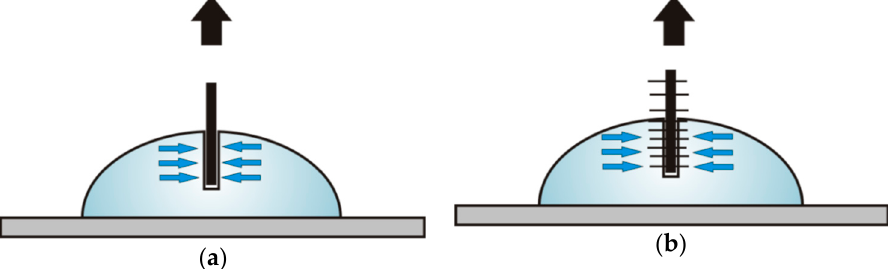
Figure 11. Schematic drawings of the effects of CNT grafting: ( a ) Wet-As-received-CF; ( b ) Wet-CNT– CF.